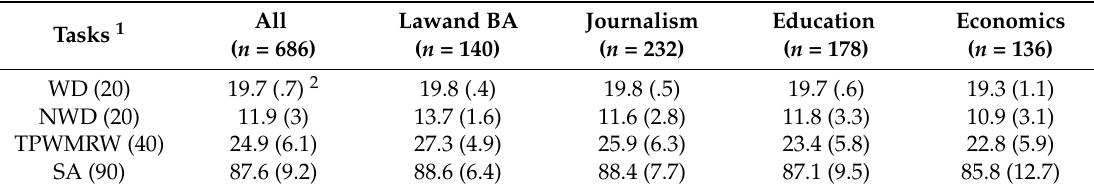
Table 1. Means and standard deviations of the tasks.